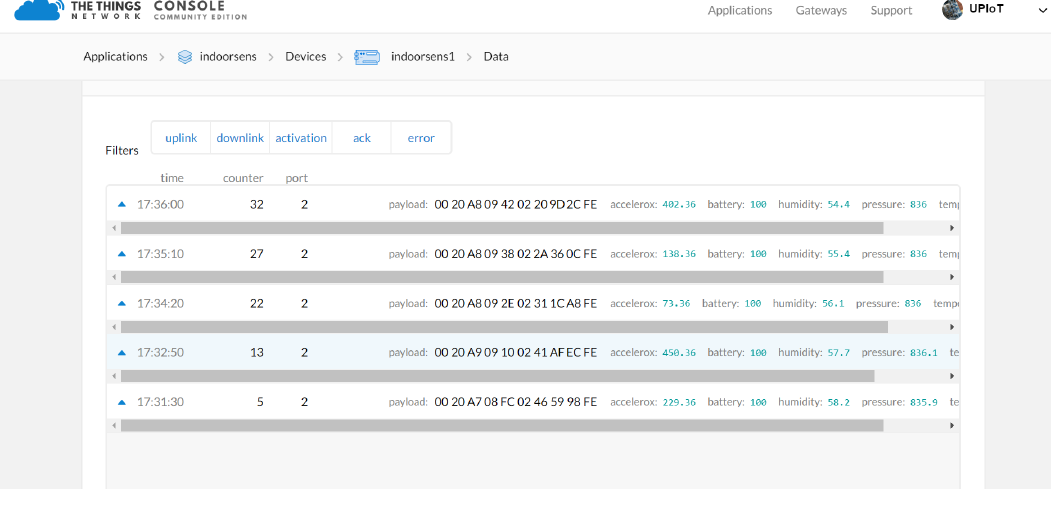
Figure 6. Data for network packets.